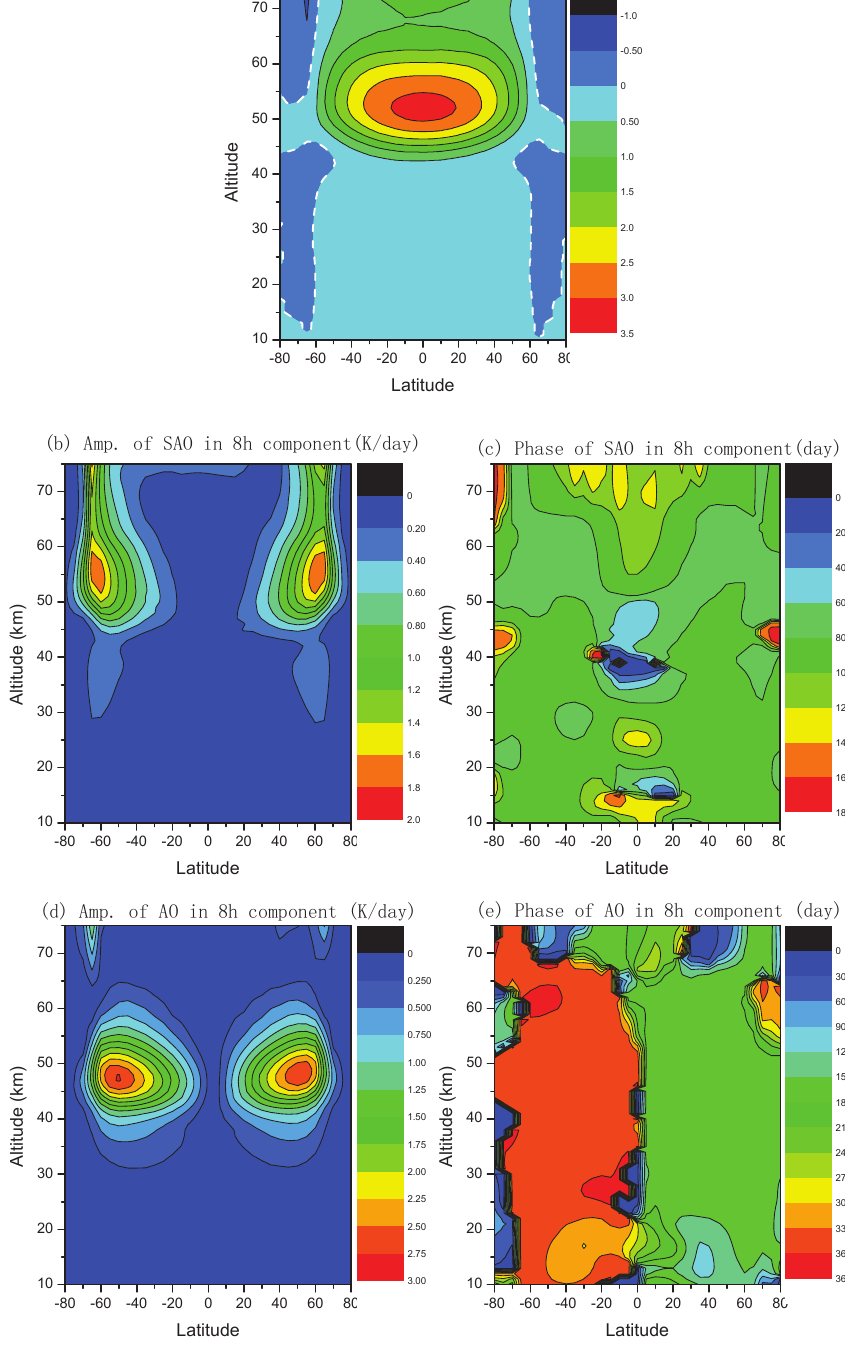
Fig. 13. The same as Fig. 9, but for terdiurnal Figure 13 The same as Figure 9, but for terdiurnal component.